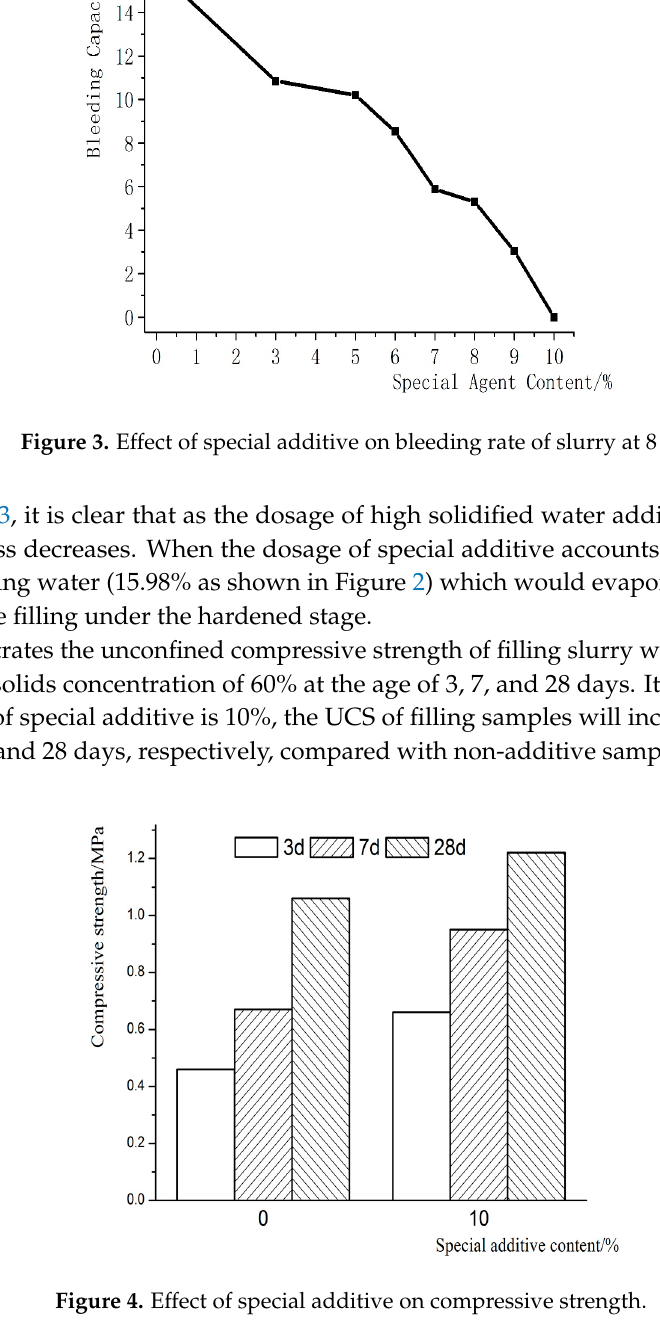
Figure 4. Effect of special additive on compressive strength.